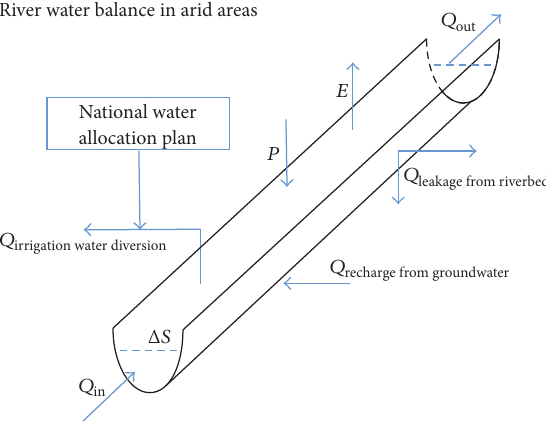
Figure 1: A water balance framework for a river flowing in arid and semiarid